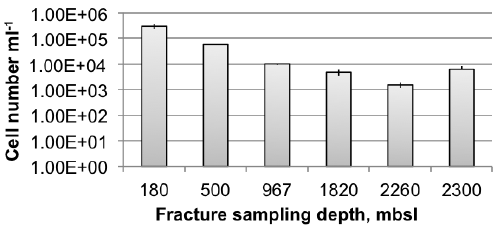
Figure 1. Total number of microbial cells in Outokumpu fracture